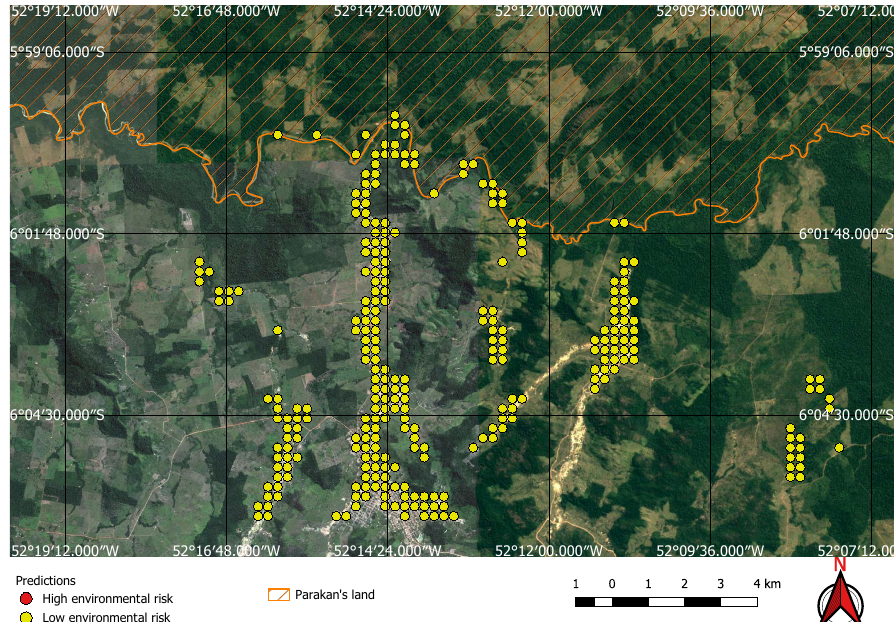
Figure 18. Mining identified by the neural network close to the Parakan’s protected land.